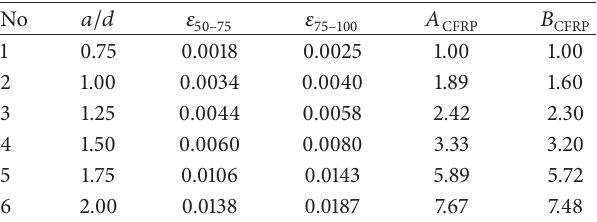
Table 5: Average transverse strains of CFRP-strengthened RC struts for different applied load levels.